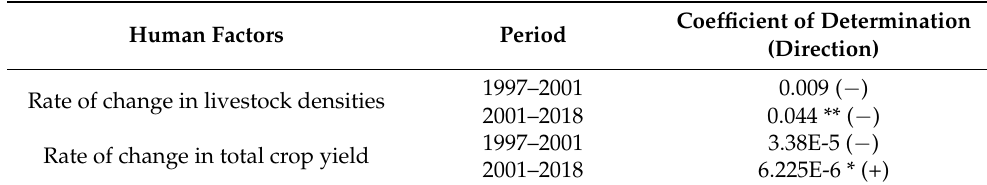
Figure 10. Changes in the number of livestock and crop yield in the Wulagai management area from 1997 to 2018.